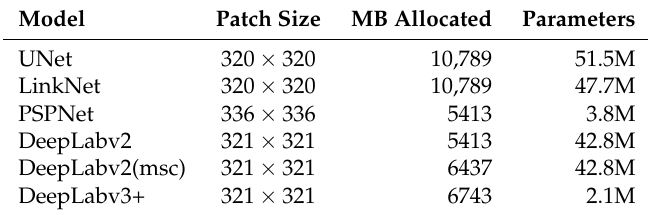
Table 3. Patch size, memory requirements and trainable parameters for each